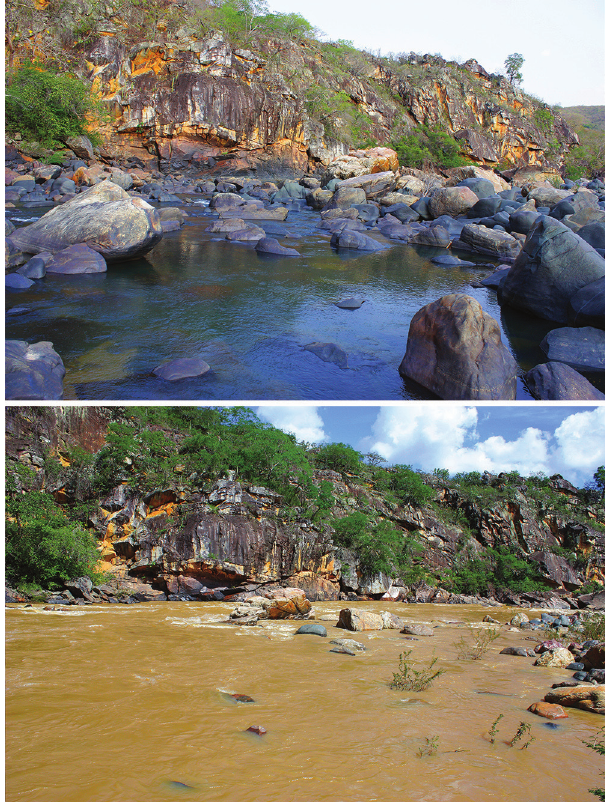
Fig. 4. Rio Itacambiruçu, where many specimens where collected, during low (above) and high (below) water